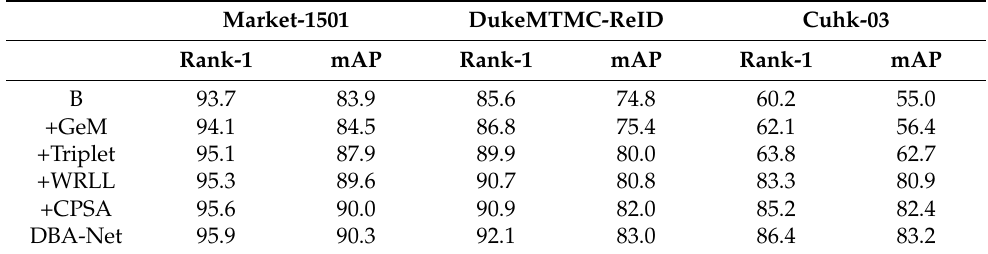
Table 6. Ablation experiments of DBA-Net.